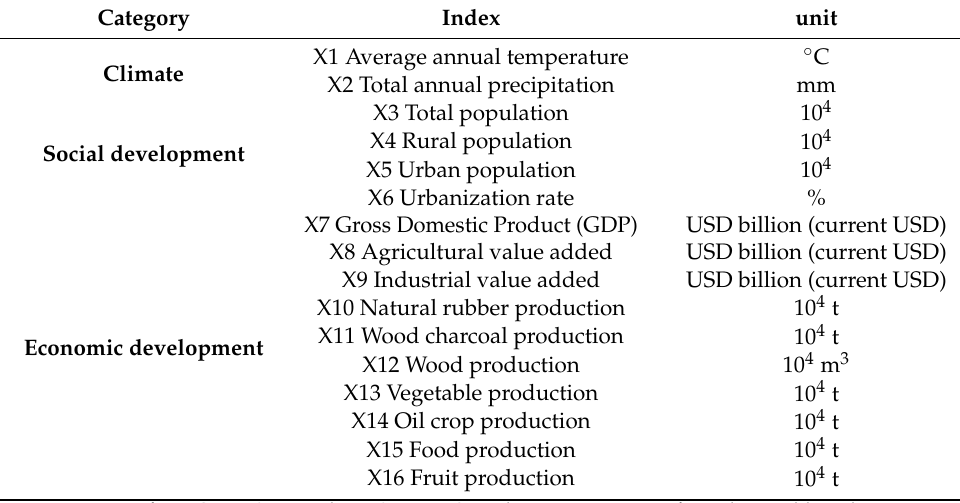
Table 3. Driving factors system of LUCC in Myanmar. Category Index